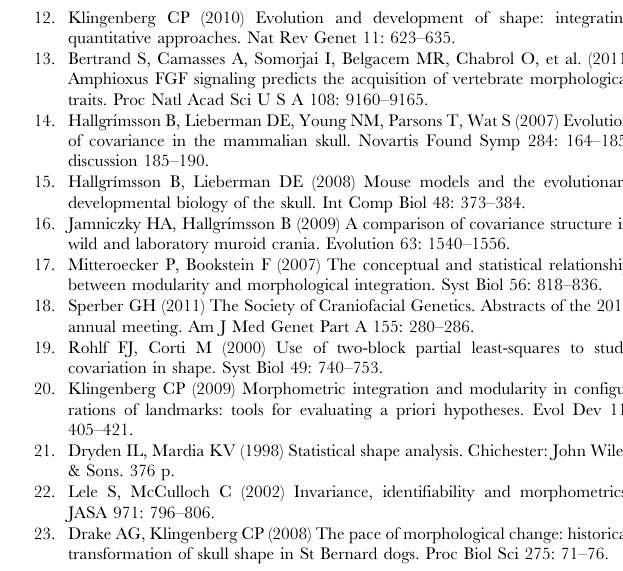
Figure S1 Histograms of the distribution of the RV coefficients computed after all possible random partitions of equally sized